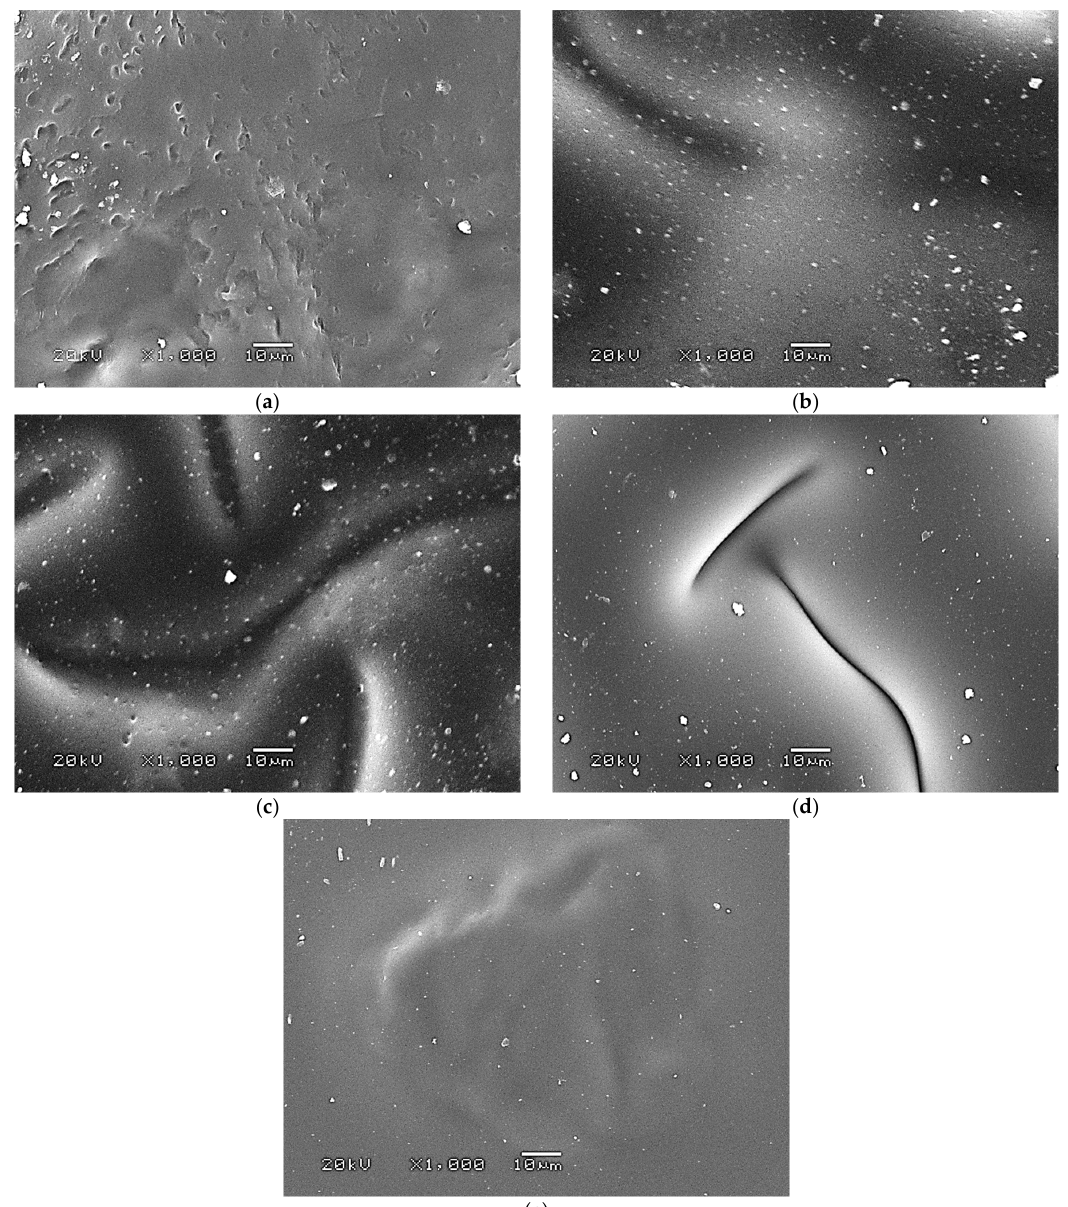
Figure 9. SEM image of sample 0.025/Photo ( a ), 0.075/Photo ( b ), 0.100/Photo ( c ), 0.125/Photo ( d ), and 0.150/Photo ( e ). and 0.150/Photo ( e